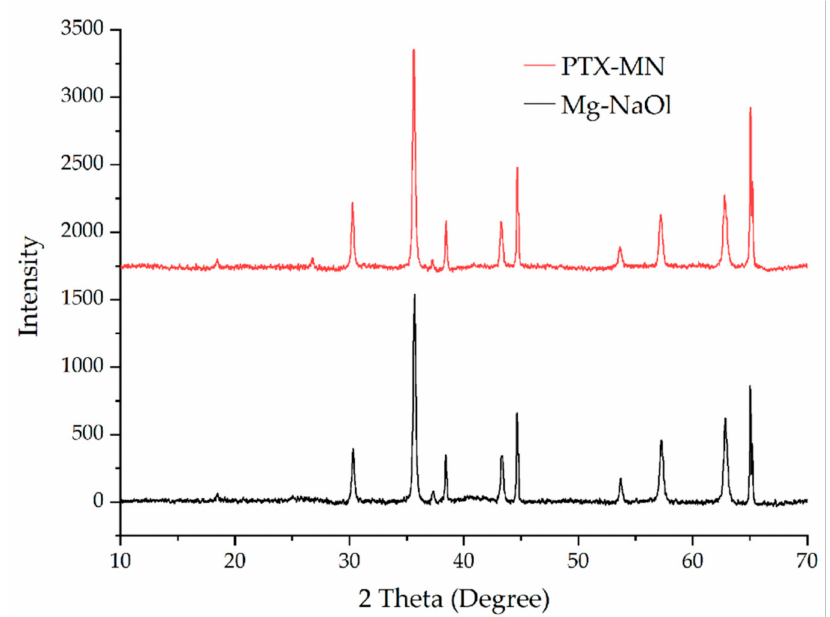
Figure 5. XRD diffractograms of Mg-NaOl and PTX-MN.